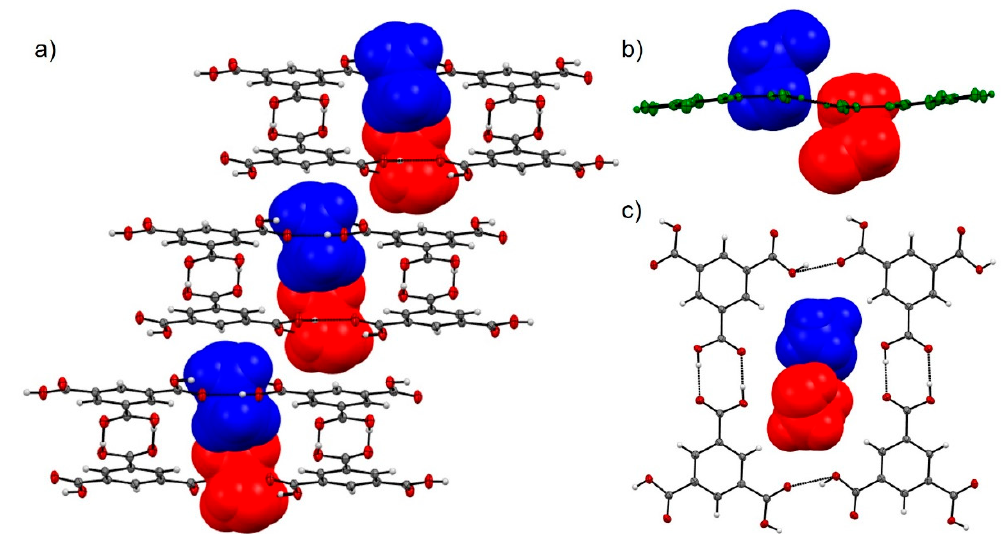
Figure 3. ( a ) The stacked nature of the tape motif that runs from left to right. The position of the ethanol molecules in the hydrogen-bonded ring system require the tapes to be offset; ( b ) a view perpendicular to the tape motifs indicating the orientation of the ethanol molecules in the ring system; ( c ) a view from the top of the hydrogen-bonded ring, the ethanol molecules are from tapes above and below.